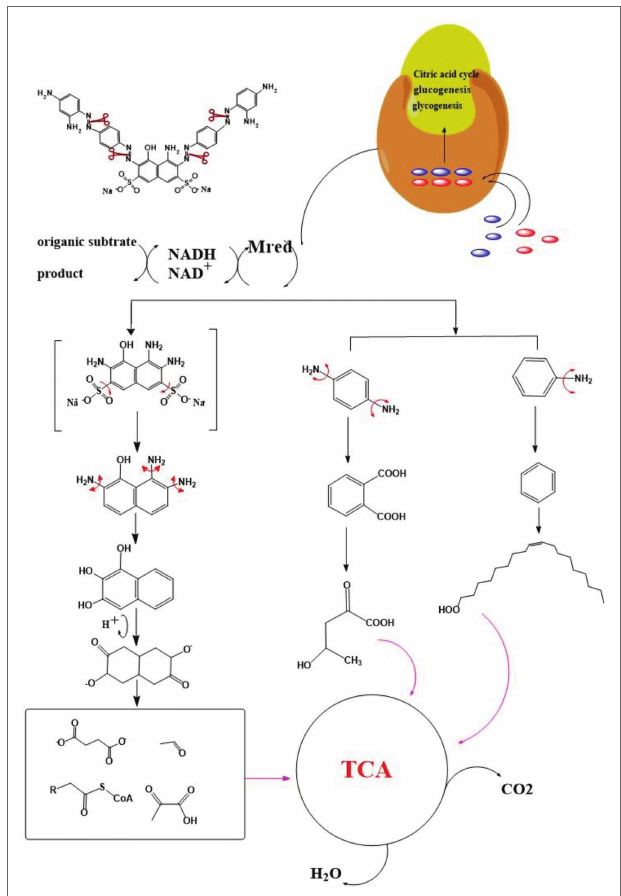
FIGURE 4 | Proposed pathway for the degradation of DBG by halophilic/ halotolerant